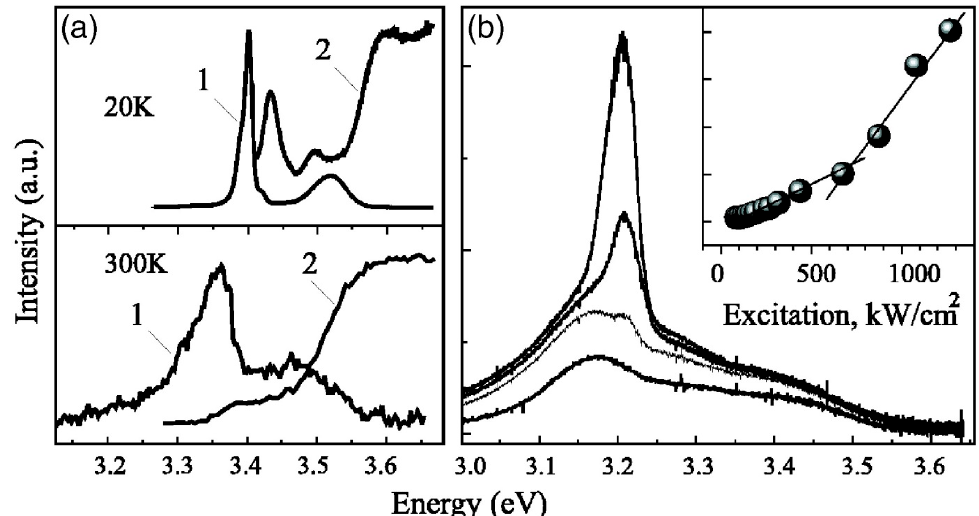
Figure 8. ( a ) Photoluminescence (1) and photoluminescence emission (PLE) (2) spectra measured in a 3nm ZnO / ZnMgO SQW separate confinement double heterostructure. The room temperature PLE spectrum is monitored from the “green” PL peak (2.393eV) for the sake of better resolution. ( b ) RT spectra of stimulated emission measured at the excitation power density (from bottom to top): 436, 674, 872, and 1079 kW / cm 2 . The inset presents the PL intensity dependence on the excitation power. Reprinted from [140], with the permission of AIP